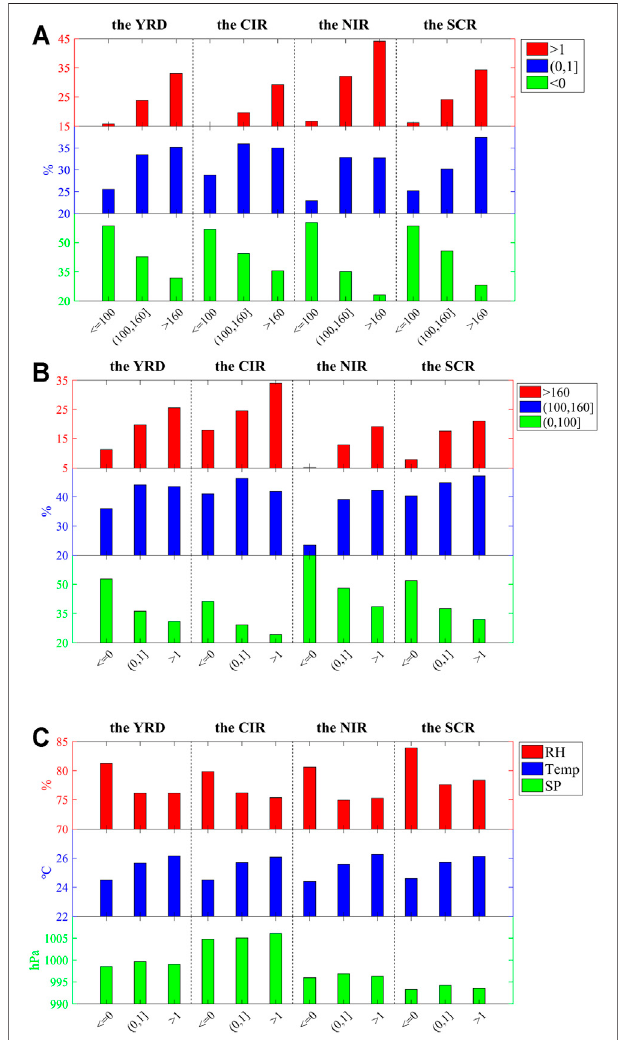
FIGURE 7 | The relations between O 3 pollution levels and air stagnation intensity in the YRD, including (A) the distribution of percentages of S n values underdifferentO 3 pollutionlevels, (B) thedistribution ofpercentagesoftheO 3 pollution levels for a given S n value range, and (C) the distribution of relative humidity (RH), 2 m air temperature (Temp) and surface air pressure (SP) for a given S n value range.